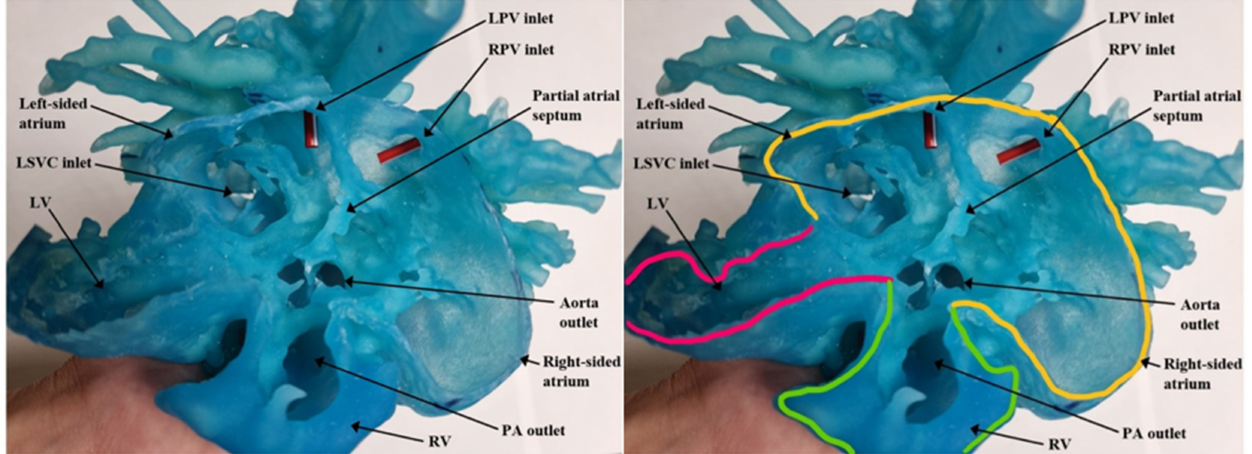
Figure 4. Apical view of the pre-operative 3D cardiac model with common atrium cut open demon- strating ipsilateral pulmonary veins and partial AV canal. Picture on the right shows the outline of the heart chambers. LPV = left pulmonary vein; LSVC = left superior vena cava; LV = left ventricle; PA = pulmonary artery; RPV = right pulmonary vein; RV = right